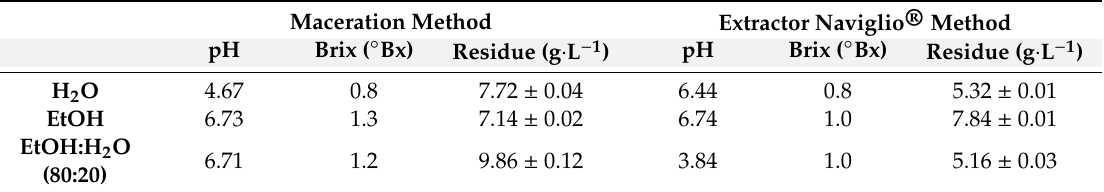
Table 1. pH, specific gravity and dry residue of the different Opuntia ficus-indica (L.) Miller fruit extracts at 24 h.